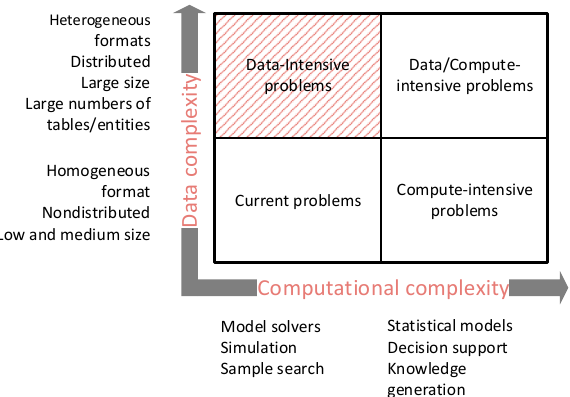
Figure 4. Data and computational complexity in Software